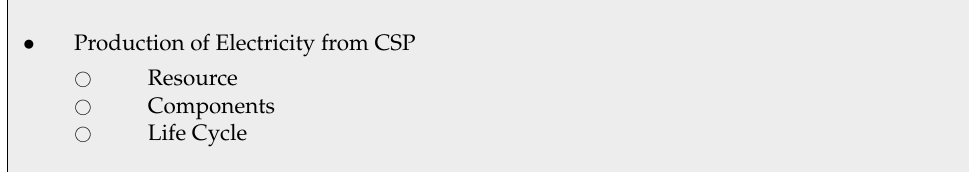
Table 7. Hierarchy for Production of Electricity from